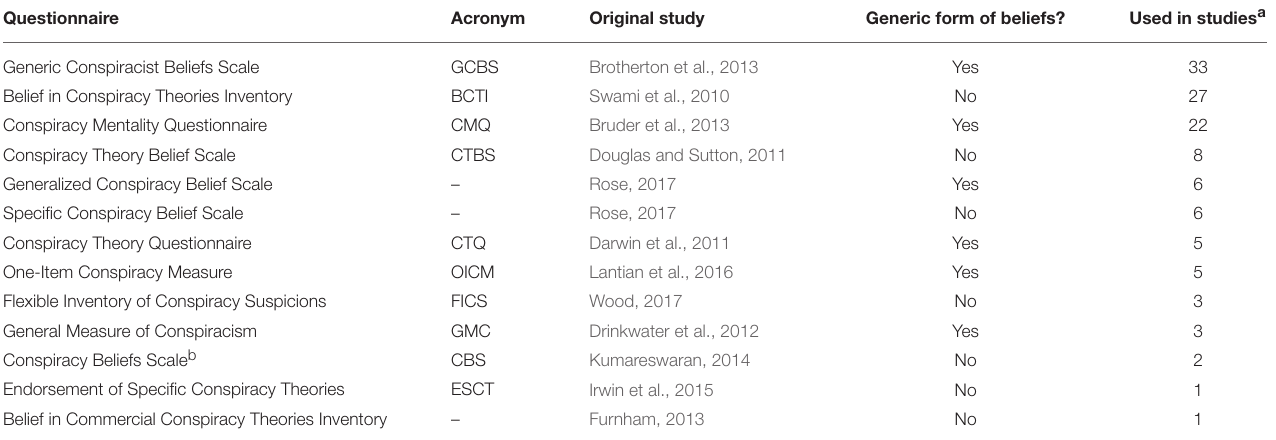
TABLE 2 | Questionnaires used in the studies included in the